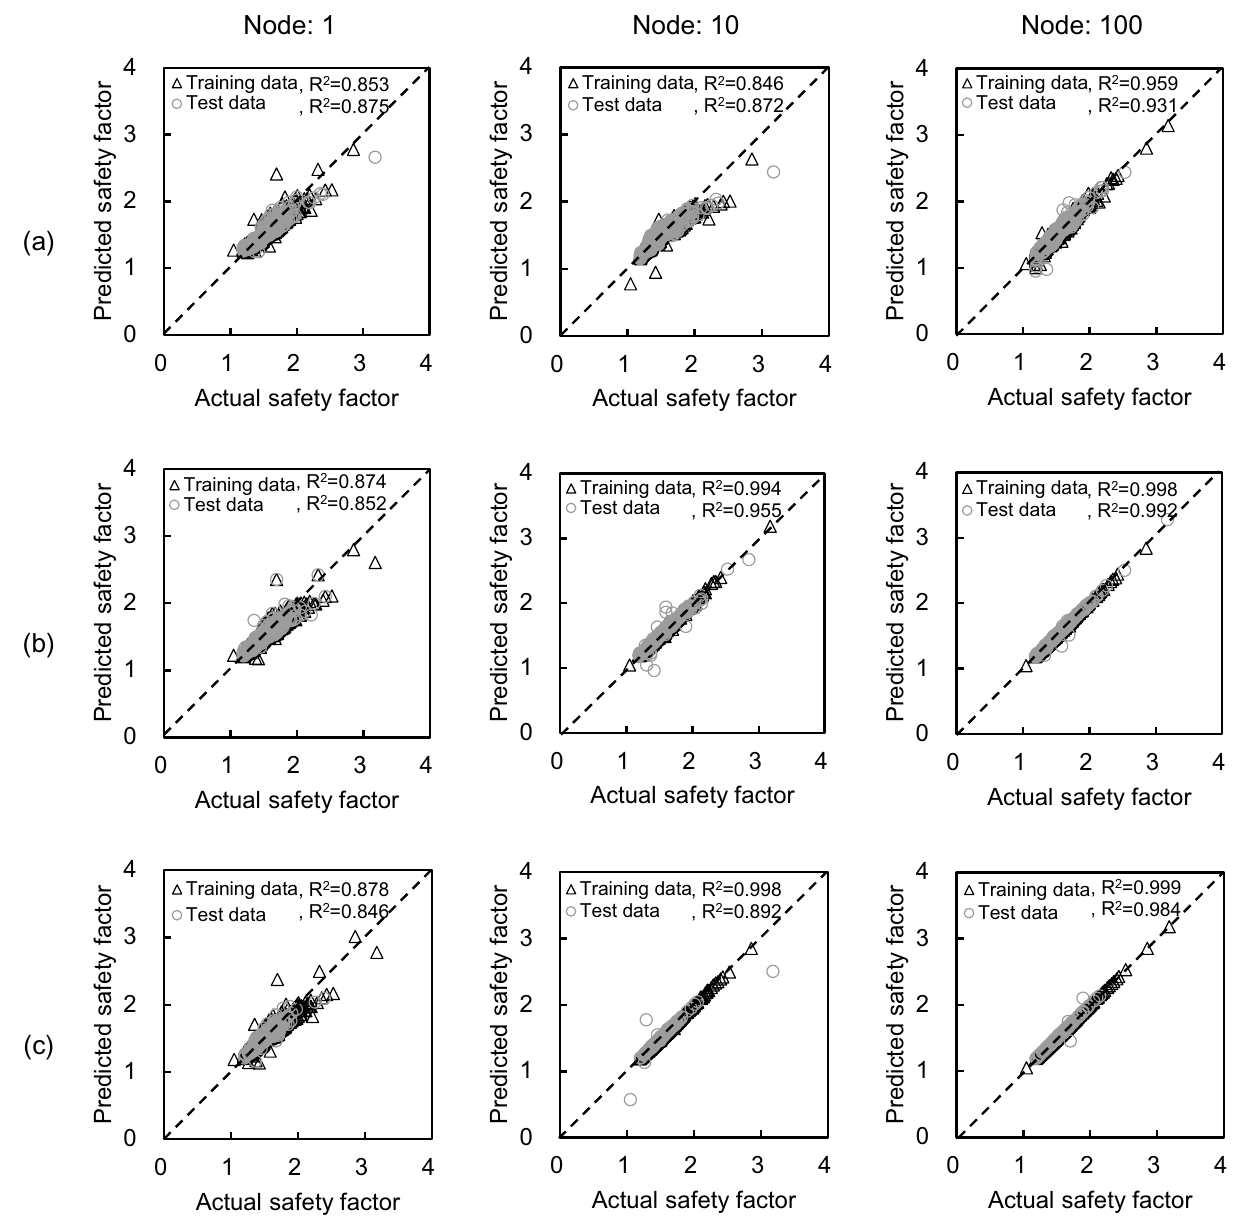
Figure 15. Comparison between predicted and actual safety factors based on neural network: ( a ) gradient descent algorithm; ( b ) Levenberg–Marquardt algorithm; ( c ) Bayesian regularization